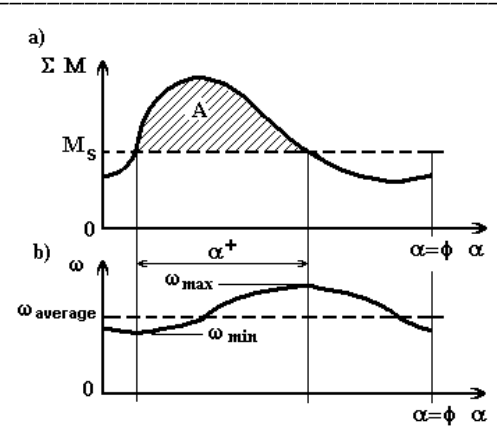
Fig. 3. Angular speed (b) and the torque (a) of the generator diagrams.